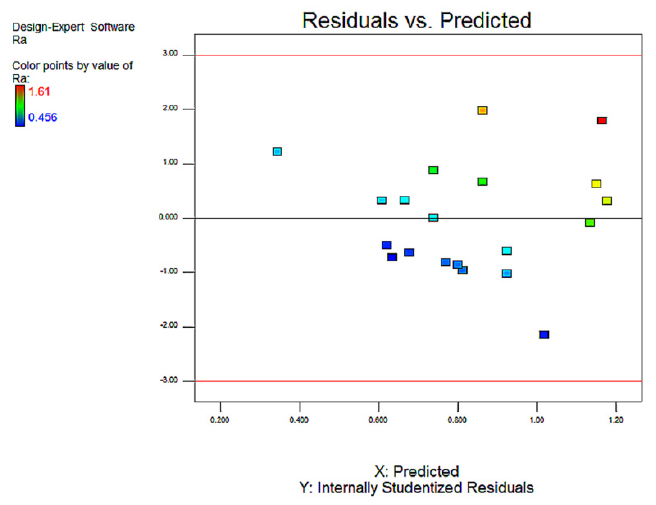
Figure 3. Normal plot of residuals for R a.